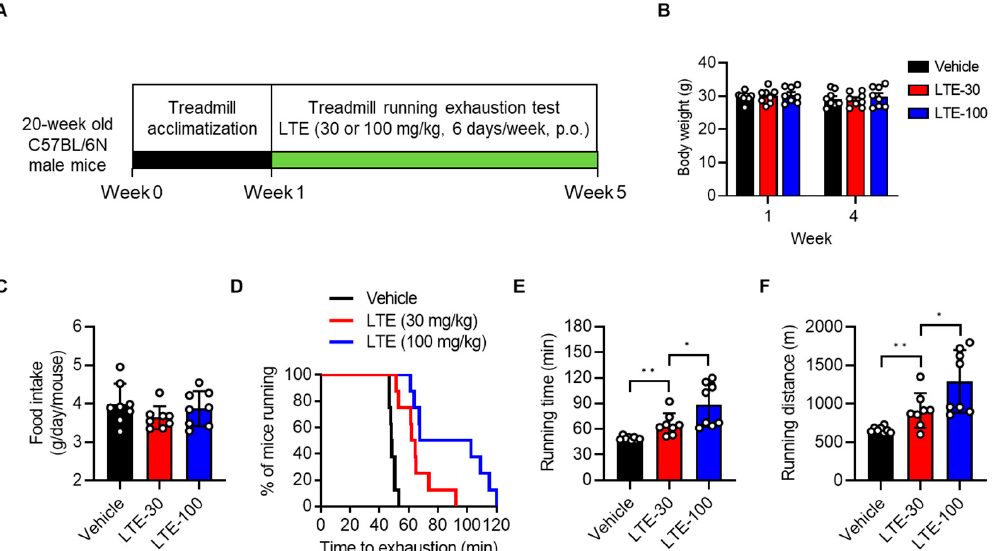
Figure 1. Analysis of Limonium tetragonum water extract (LTE). ( A ) LC/Q-TOF MS chromatogram (intensity measured in counts per second, cps) of LTE using negative ion mode. ( B ) Structures of the predominant substances in LTE. ( 1 ): epicatechin ( 2 ): ( − )-epigallocatechin-3-gallate, ( 3 ): myricetin-3- O- β -D-galactopyranoside, ( 4 ): myricetin-3-O- α -L-rhamnopyranoside, ( 5 ): myricetin-3-O-(2 ″ -O-gal- loyl)- α -L-rhamnopyranoside, and ( 6 ): myricetin-3-O-(3 ″ -O-galloyl)- α -L-rhamnopyranoside.